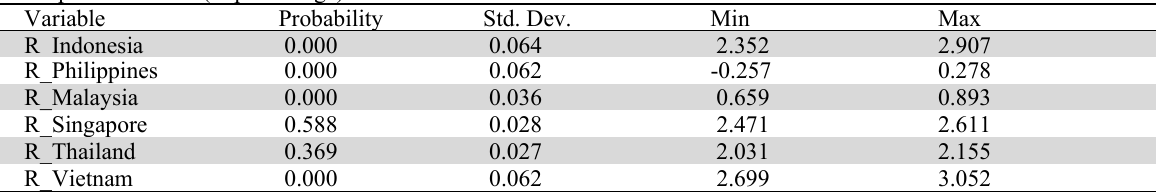
Descriptive Statistics (in percentage) Variable Probability Std. Dev.